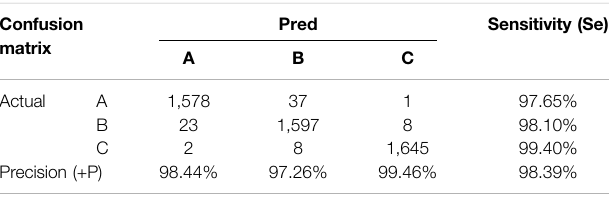
Pred Sensitivity